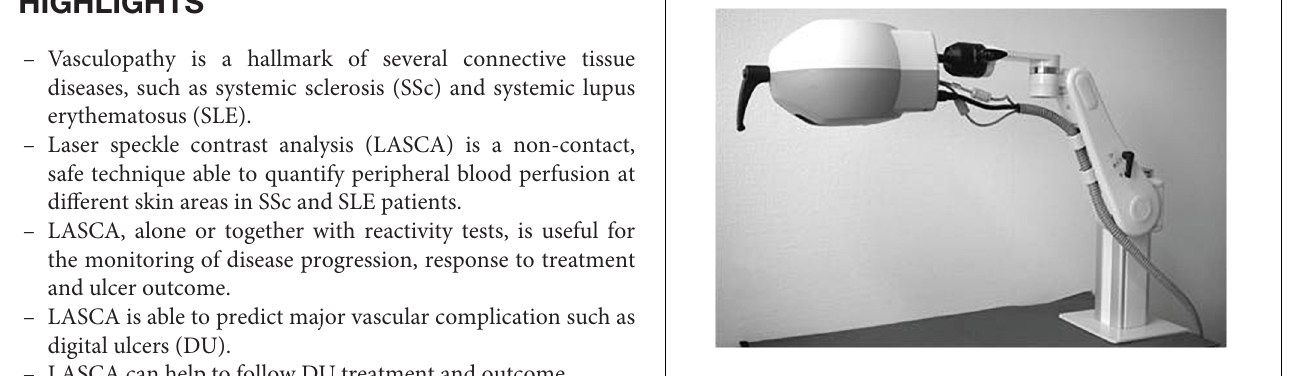
FIGURE 1 | Laser speckle contrast analysis (LASCA) is composed of: a head, an adjustable arm, a detector camera and a software for data acquisition and analysis. (Courtesy by